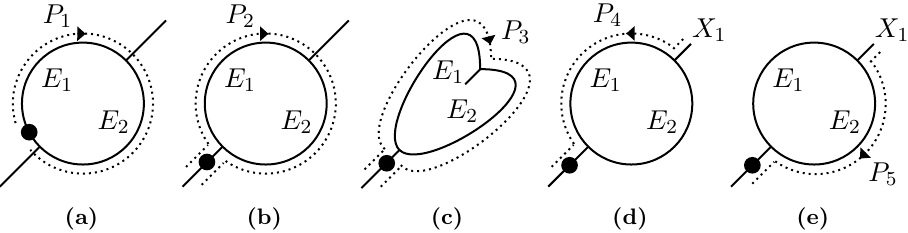
Figure 10. Some examples of graphs (cid:0) with paths corresponding to loops ((cid:12)gure 10a{(cid:12)gure 10c) and local coordinates at punctures ((cid:12)gure 10d{(cid:12)gure 10e). The base points B are marked as large